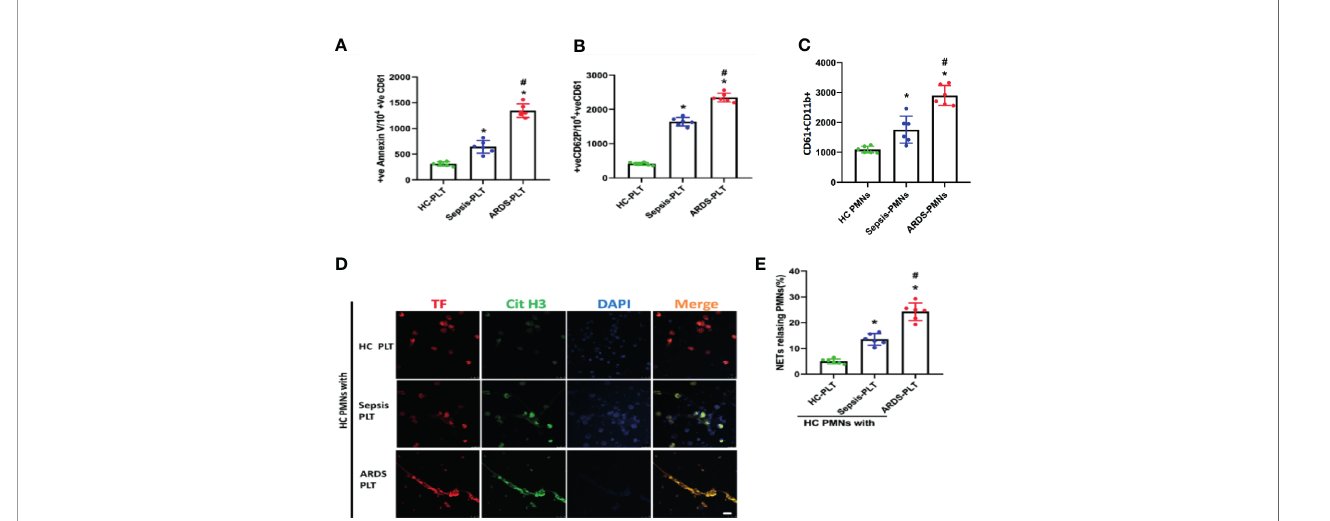
FIGURE 4 | Platelets activated in ARDS are able to induce NET formation. (A) Fluorescence-activated cell sorting analysis of Annexin V on platelets of HC platelets, sepsis patients, and ARDS patients (n=6). (B) Fluorescence-activated cell sorting analysis of CD62P on platelets of HC platelets, sepsis patients, and ARDS patients (n=6). (C) Platelet/polymorphonuclear neutrophil aggregates observed as double-positive CD61/CD11b per 10000 CD11b-positive events with fl uorescence- activated cell sorting analysis in polymorphonuclear neutrophils isolated from HC, sepsis, and ARDS patients (n=6). (D) NET generation by control polymorphonuclear neutrophils treated with platelets isolated from the 3 groups. The sections were immunostained with TF (red) and CitH3 (green), and DAPI (blue) was used to counterstain the nuclei. (E) Percentage of NET-releasing PMNs (n=6). P < 0.05 (*) and P < 0.05 ( # ) compared to baseline healthy controls and the sepsis group were considered statistically signi fi